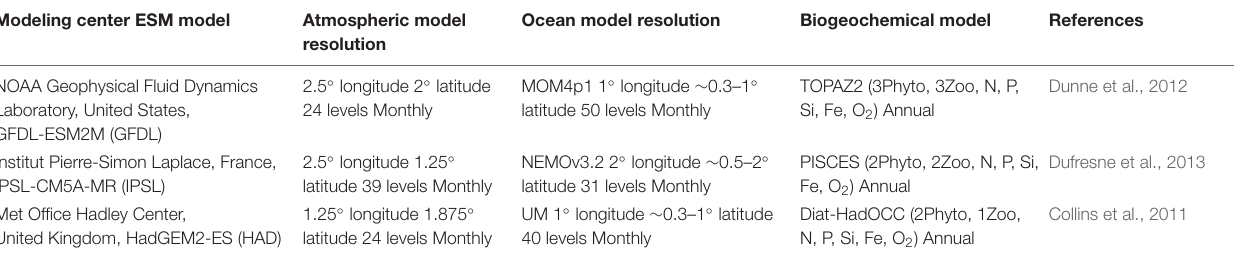
TABLE 1 | Characteristics of the ESMs selected for regional